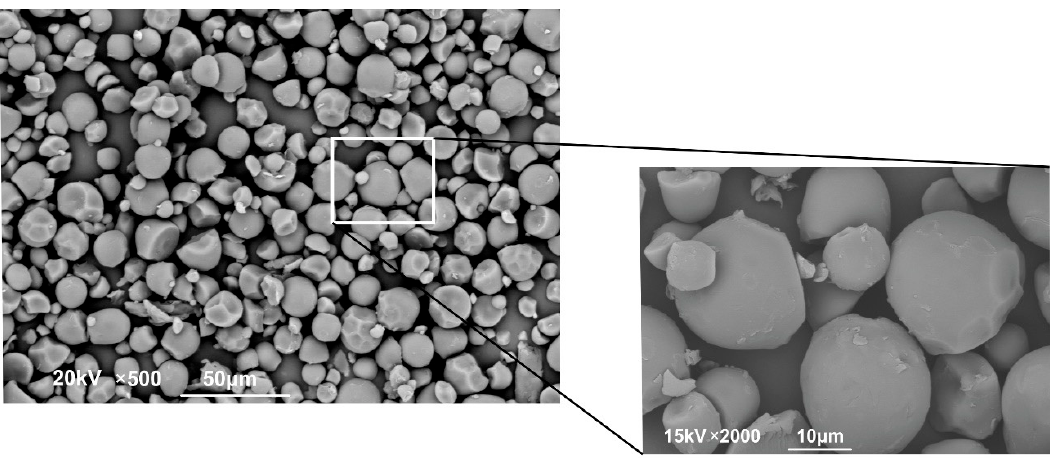
Figure 9. Micrographs of the powder formed following incorporation of the extract of H. macrocarpa on nanocellulose extracted from banana pseudo-stems: 2000× and 500× magnification.